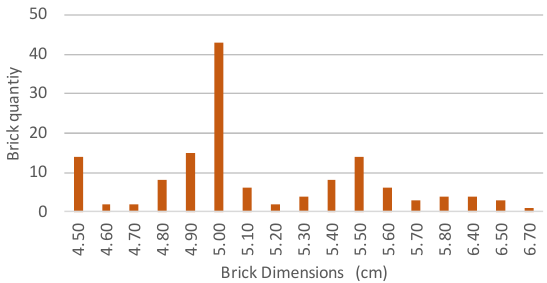
Figure 7. Example of the brick dimensions (thickness) distribution obtained by direct measurements carried out at the base of Trotti Palace courtyard walls.